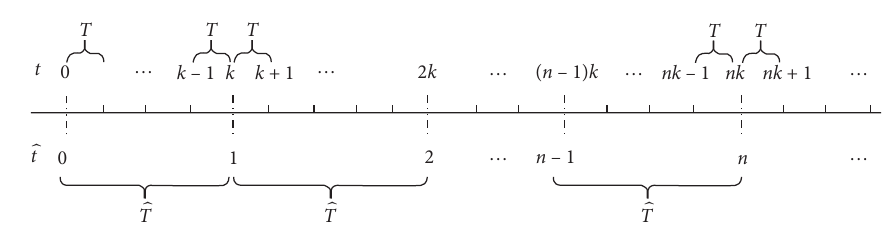
Figure 2: Model of scheduling time.